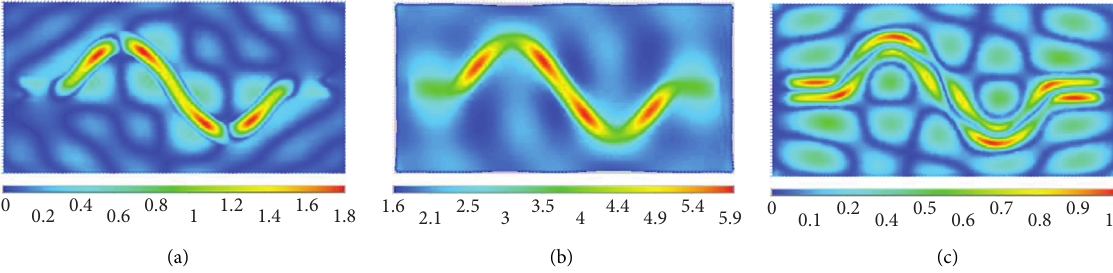
Figure 38: SH wave incident ( C